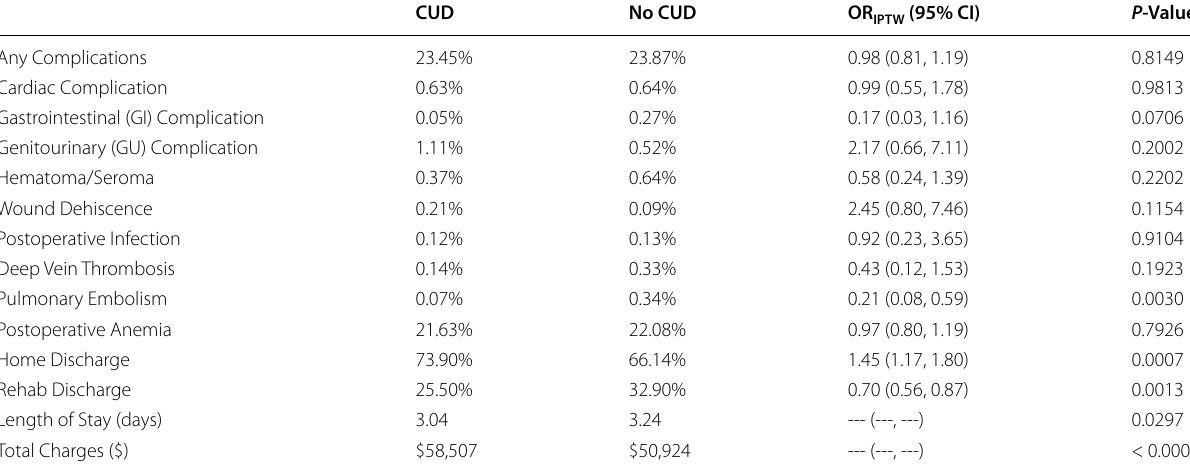
Table 4 Complication, economic, and disposition outcomes, stratified by CUD versus no